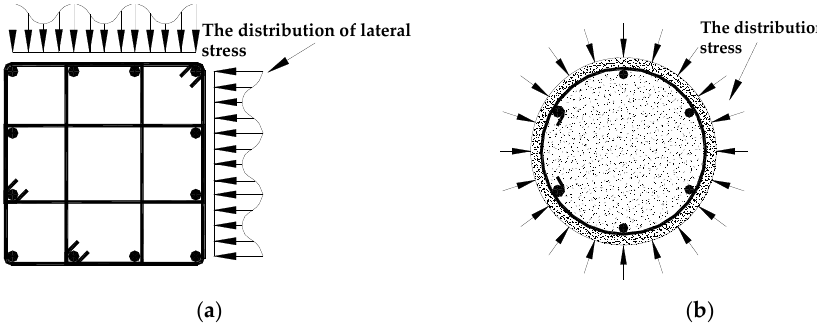
Figure 5. Passive confined stress that develops in the sections: ( a ) Rectangular or square cross-section; ( b ) Circular cross-section.